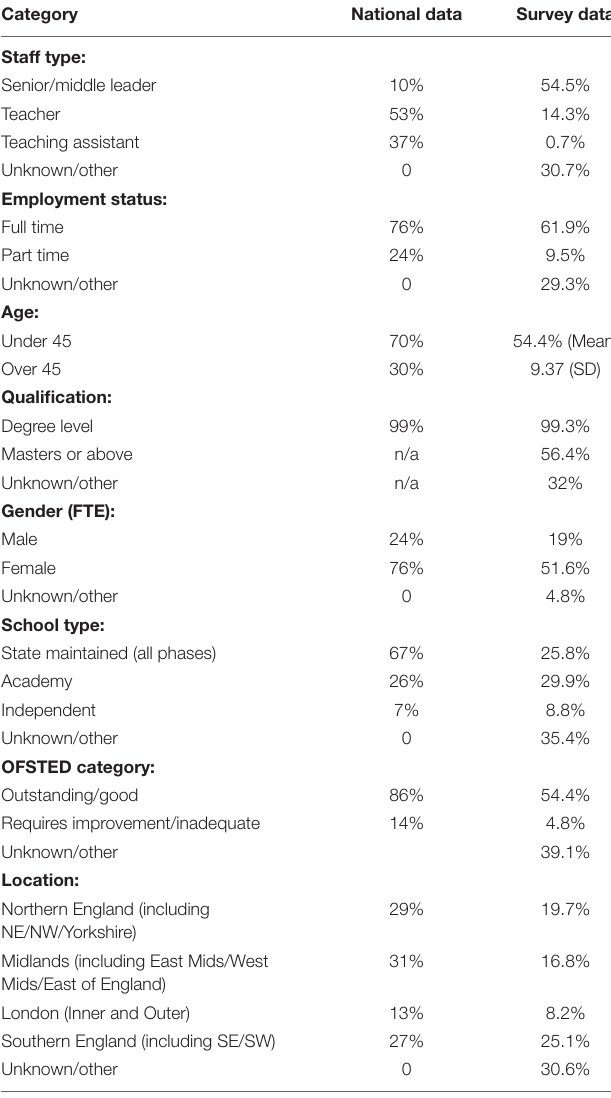
TABLE 3 | Comparison of National data (2019) with Survey data. Category National data Survey